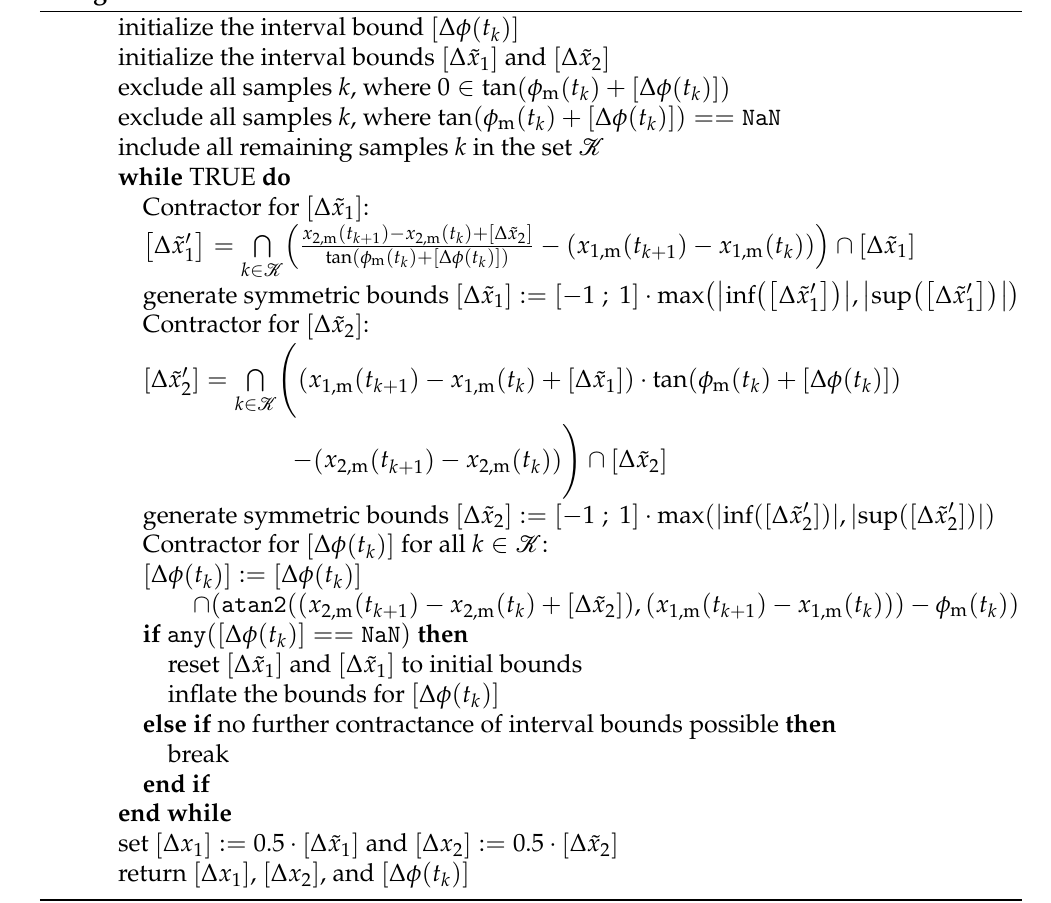
Algorithm 1: Contractor-based sensor